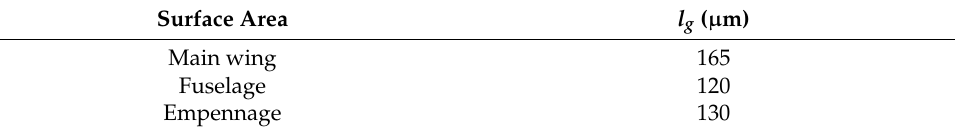
Table 2. Size of riblets applied on each surface area of the UAV.